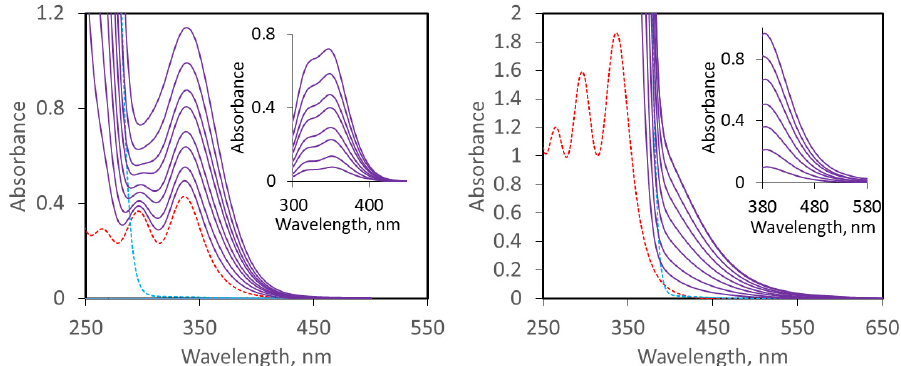
Figure 2. Spectra of solutions with a constant concentration of CHI 3 and various concentrations of DABCO ( left ) and TMPD ( right ). Spectrum of the solutions of individual reactants are shown as dashed red (CHI 3 ) or blue (DABCO and TMPD) lines. Inserts: Spectra of the complexes obtained by subtraction of the absorption of components from the spectra of their mixtures.